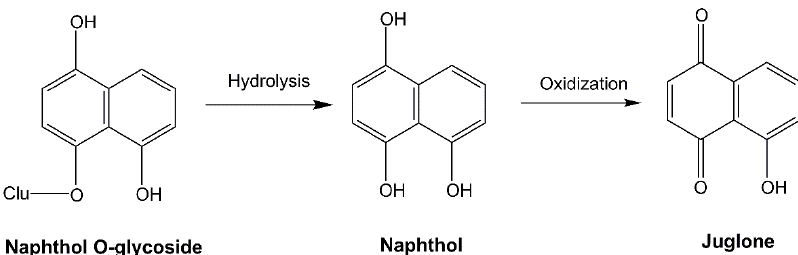
Figure 1. The first allelochemical juglone originated from black